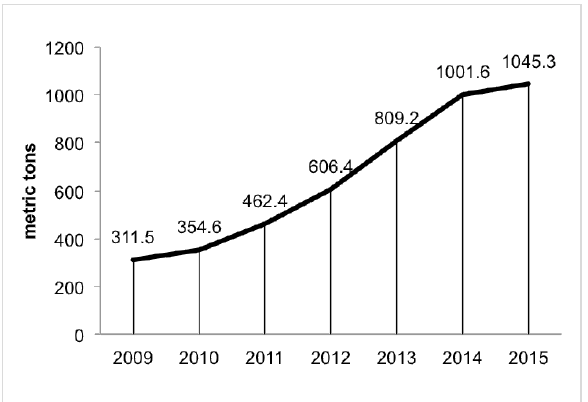
Figure 1: The estimated demand of for nevirapine until 2015 [6].